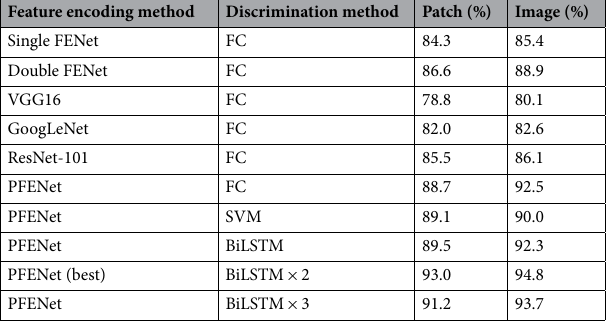
Table 4. Performance comparison of various network architecture combinations.